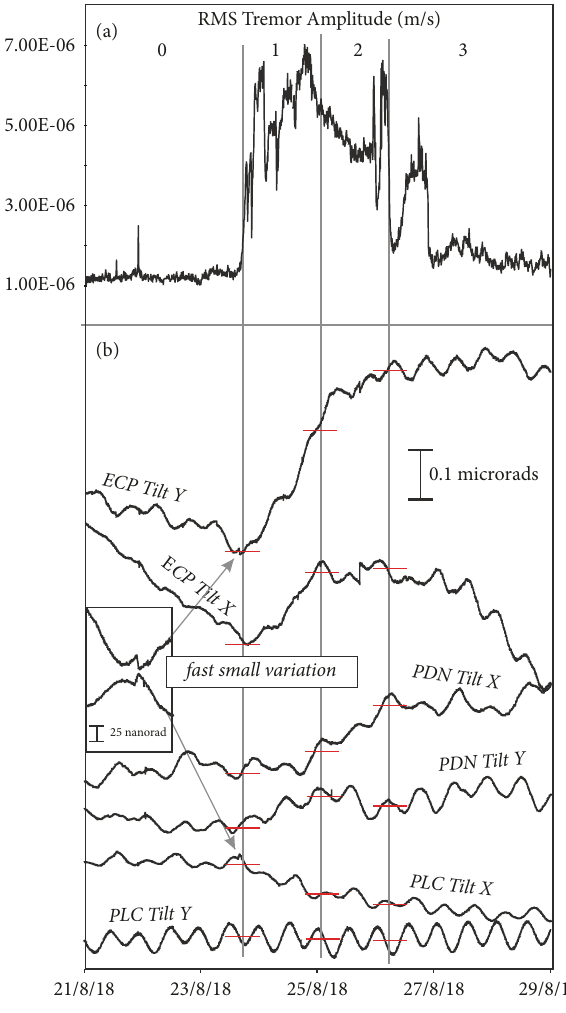
Figure 5: Volcanic tremor (a) and tilt components at the three stations (b). Red dashes mark the measured reference points for tilt changes (see also Table 2). Numbers indicate the preactivity (0), main variations (1) , minor changes (2) , and end of activity (3) phases. Inset reports the magnification of the small fast variation recorded at ECP and PLC just before onset of volcanic